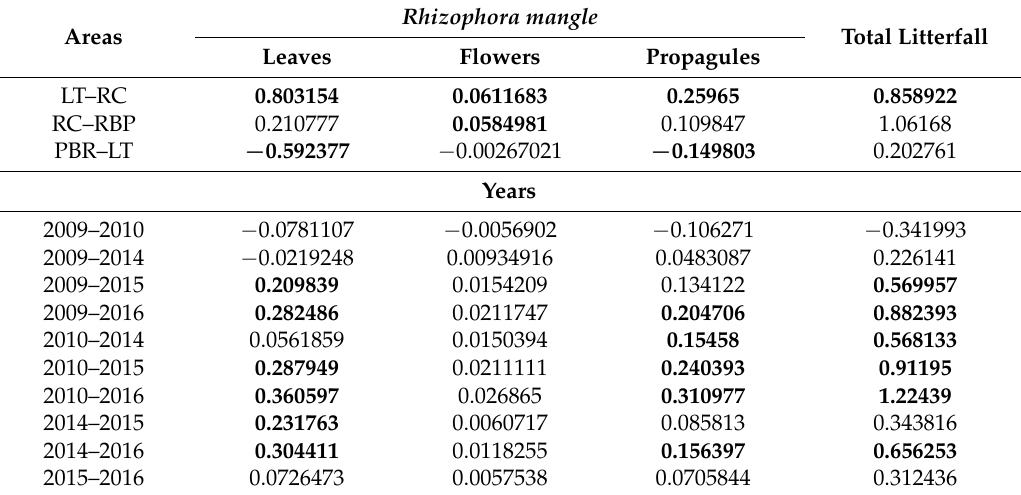
Table 7. Summary of Fisher’s Least Significant Difference post hoc tests conducted for the factorial ANOVA on litterfall production and components comparing the areas and years. Bold values are significantly different ( p <